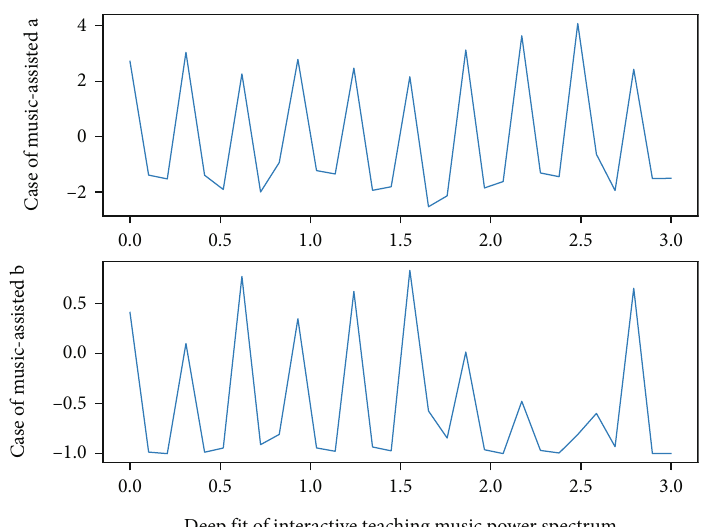
Figure 3: Distribution of deep fi t of music-assisted interactive